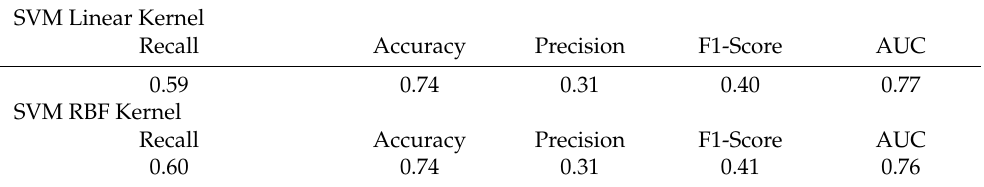
Table 6. Performance metrics of SVM Models.